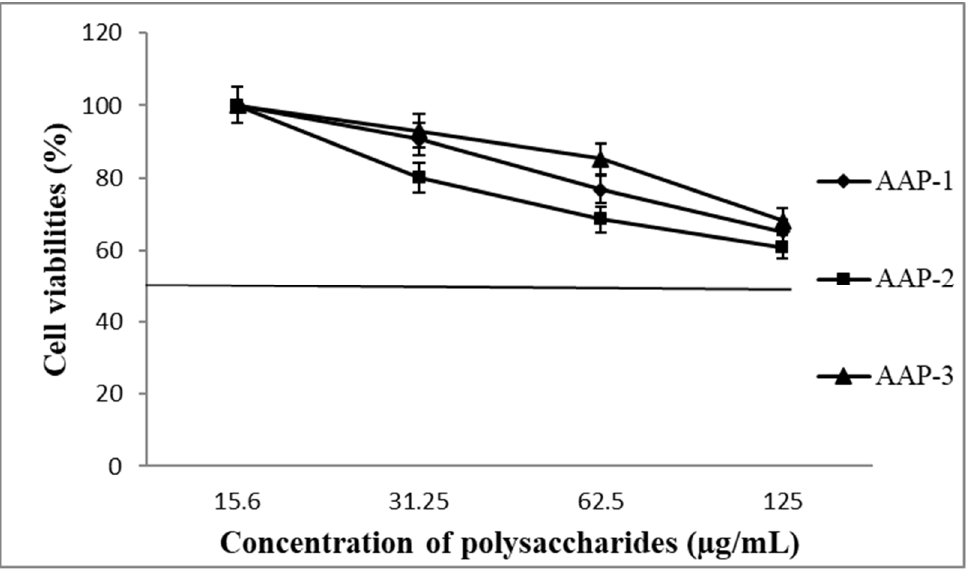
Figure 8. Cell viabilities of isolated polysaccharide fractions from A. annua at different concentra- tions.